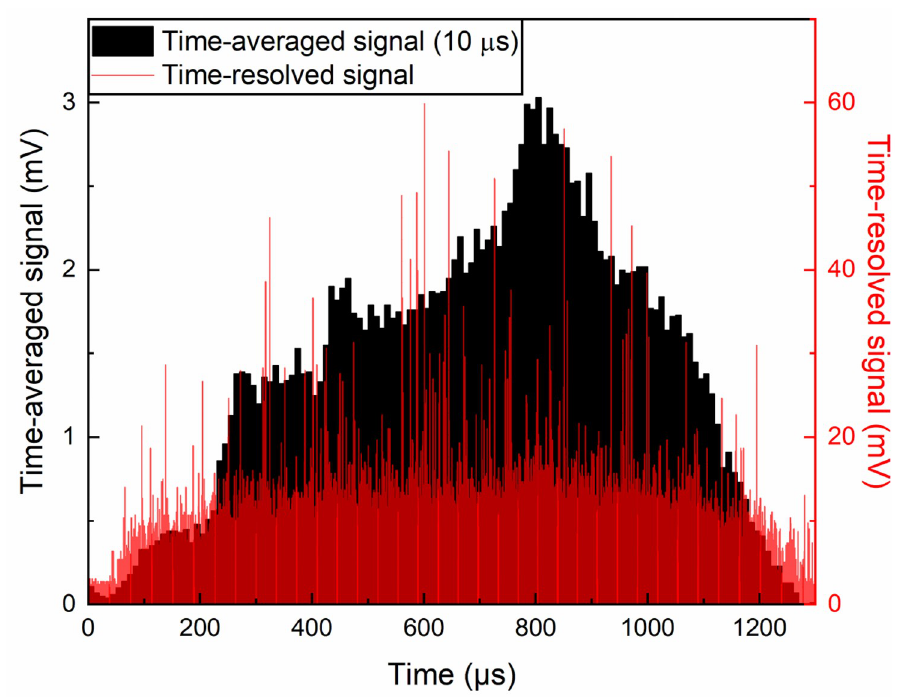
Fig 2. Time-averaged and time-resolved Rayleigh scattering signals. The red lines indicate time-resolved Rayleigh scattering signals from methane clusters produced at a backing pressure of 20 bar with a 1 ms valve opening time. The black bars indicate time-averaged signals during 10 μ s intervals. The time-averaged signal reaches its peak around 800 μ s with a full width at half maximum of ~700 μ s.